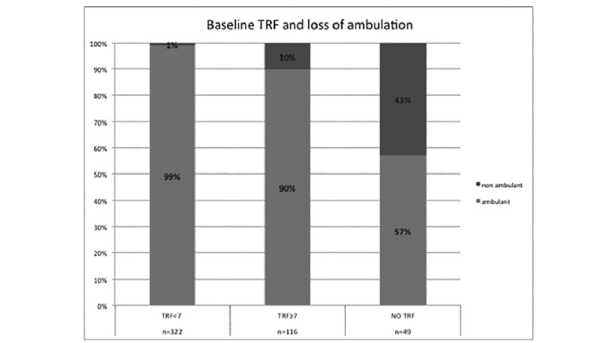
Fig 2. Percentage of patients losing ambulation in subgroups subdivided according to TRF performance.